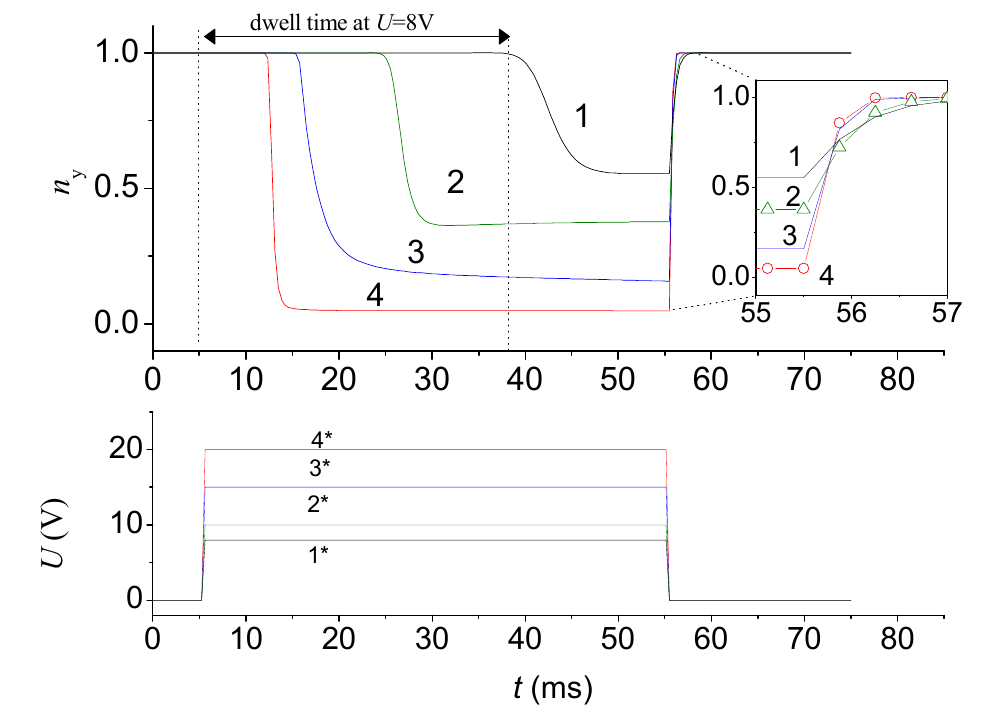
Figure 6. Dynamic response of the director state ( n y -component, top) to the applied voltage pulse (bottom).